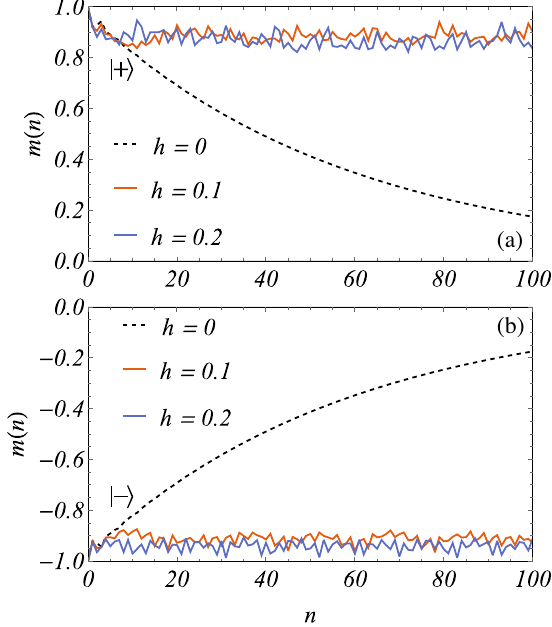
FIG. 5. Floquet dynamics of the order parameter induced by the kick K ϵ , with ϵ ¼ 0 . 2 and different values of h , in an infinite ;h chain L ¼ ∞ , obtained through iTEBD simulations. The system is initially prepared either (a) in the “ vacuum ” jþi or (b) in the “ false vacuum ” j − i . The order-parameter meltdown for h ¼ 0 (dashed black lines) gets strongly suppressed by the presence of a small h ≠ 0 (solid